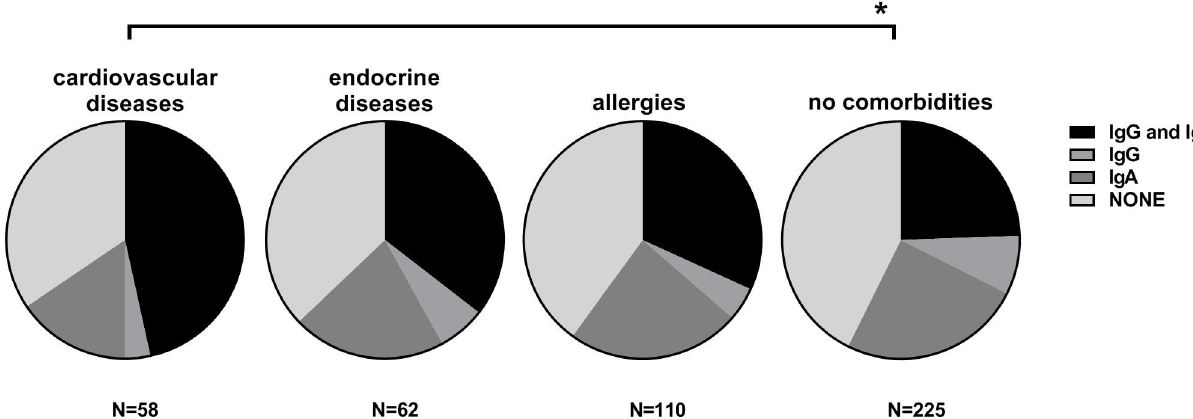
Fig 2. Correlation between comorbidities and antibody responses to SARS-CoV-2.